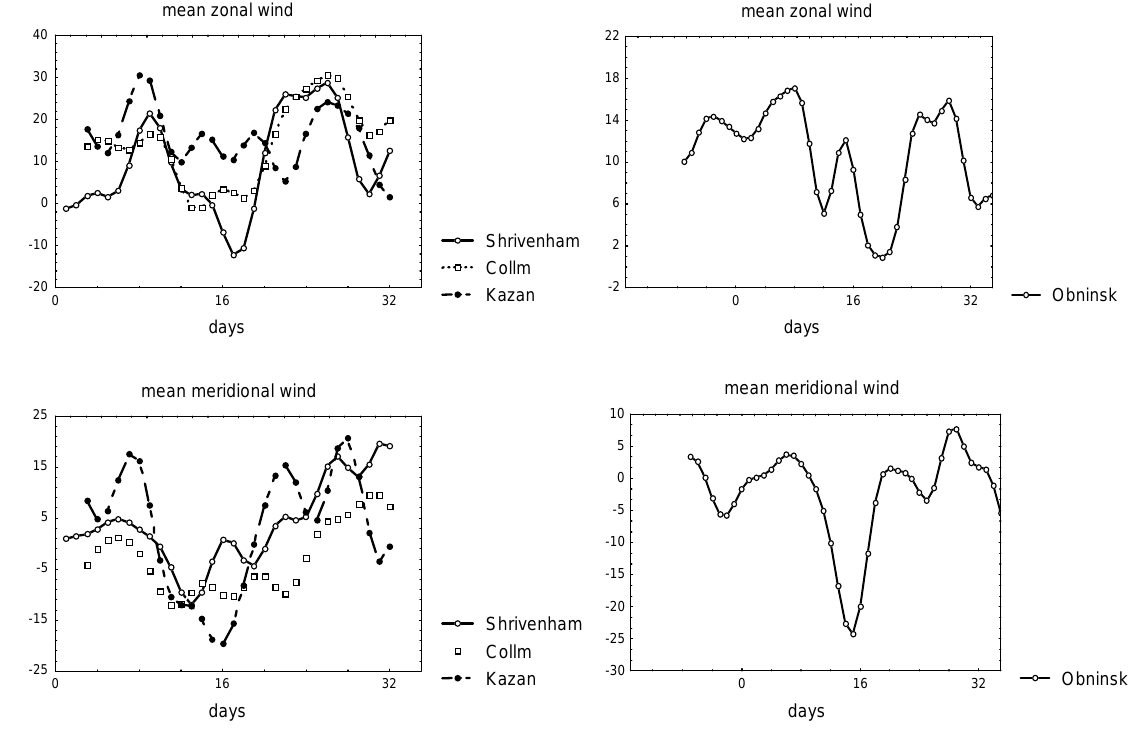
Fig. 16. Mean wind variations during December